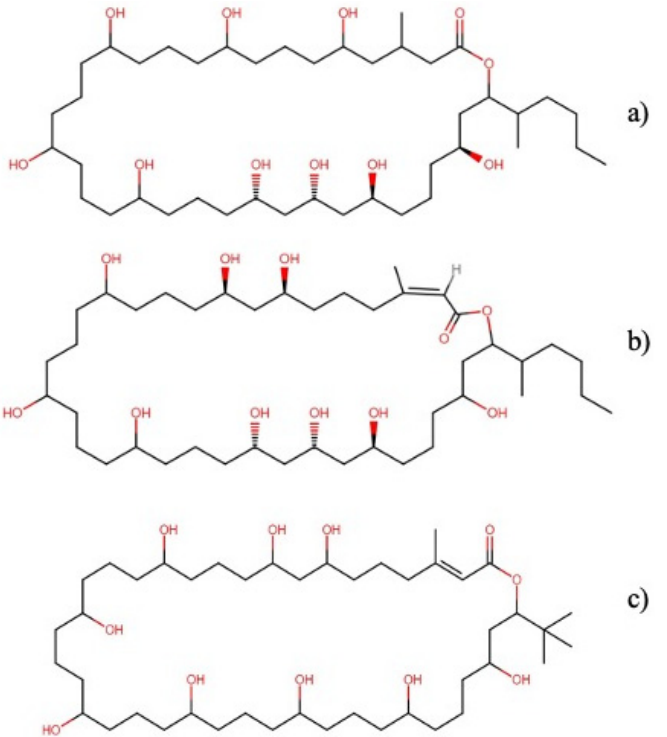
Figure 2. Chemical structures of ( a ) caylobolide A, ( b ) caylobolide B, and ( c ) nuiapolide.